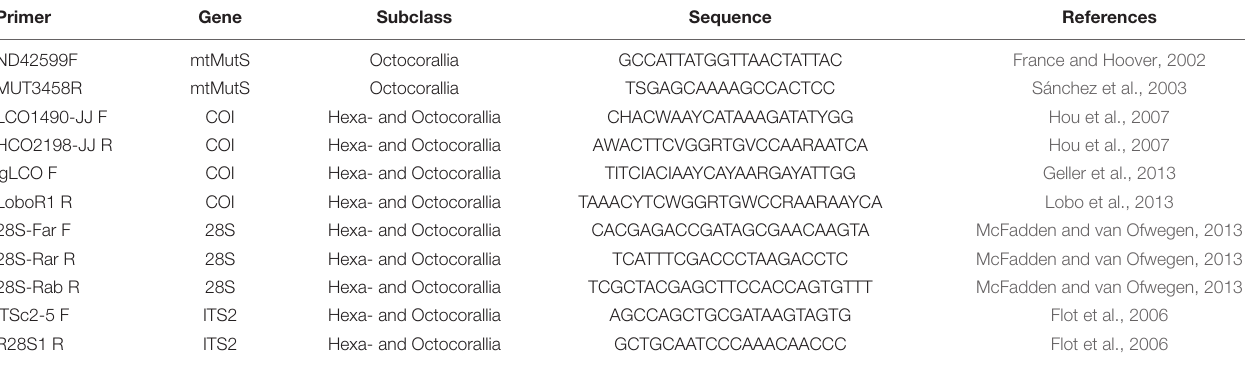
Values in brackets indicate PCR conditions for Touch-up PCR. TABLE 2 | Primers used for the amplification of the mitochondrial and nuclear genes in this